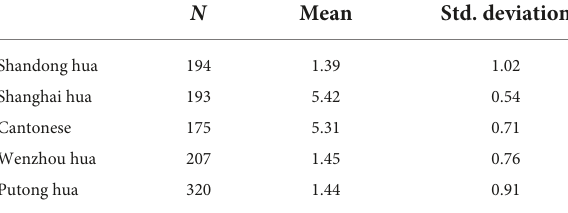
TABLE 6 Social motivation by